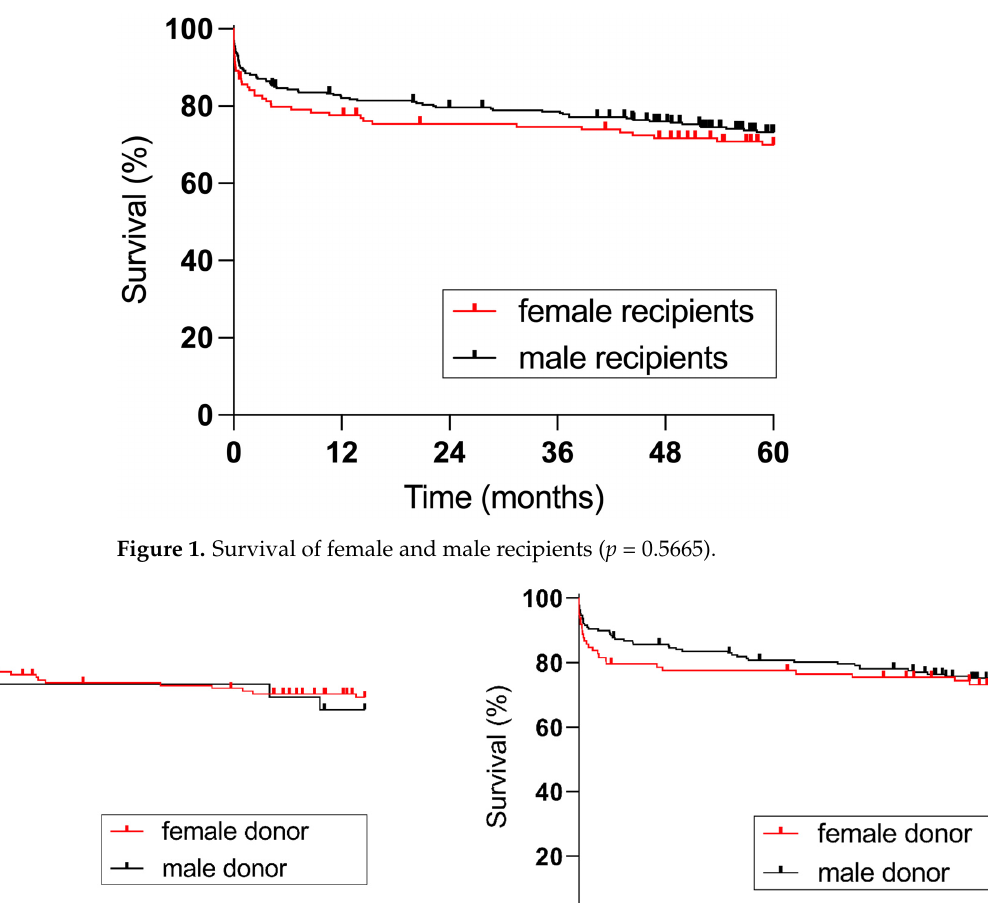
Table 4. Results from Cox regression analysis of factors independently associated with postopera- tive survival.